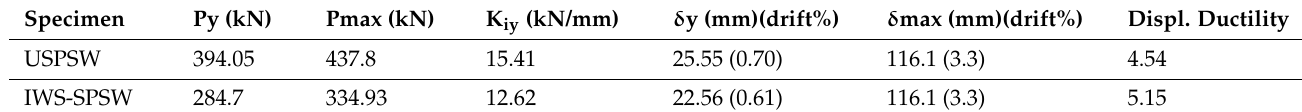
Figure 9. Envelope curve corresponding to IEP curve of test specimens.